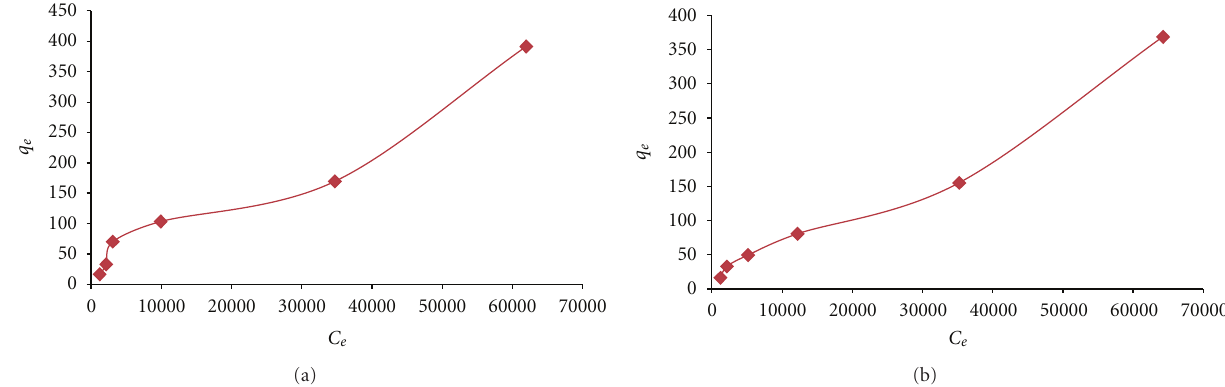
Figure 4: BET adsorption isotherms of lead sorption by hybrid active carbons (a) Ox-AC-BY and (b)